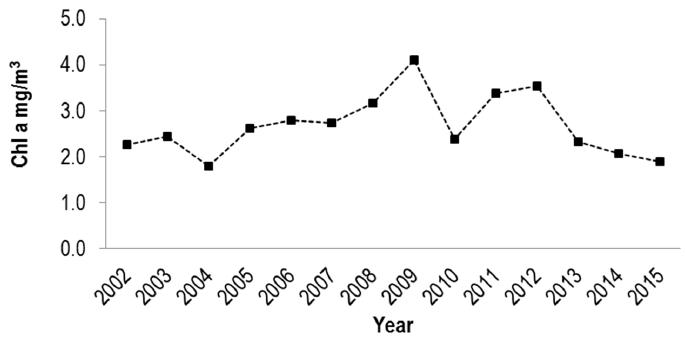
Figure 9. Average annual variability of chlorophyll a in the central and southern coastal region of Sonora, Mexico, and adjacent oceanic zone in the Gulf of California.